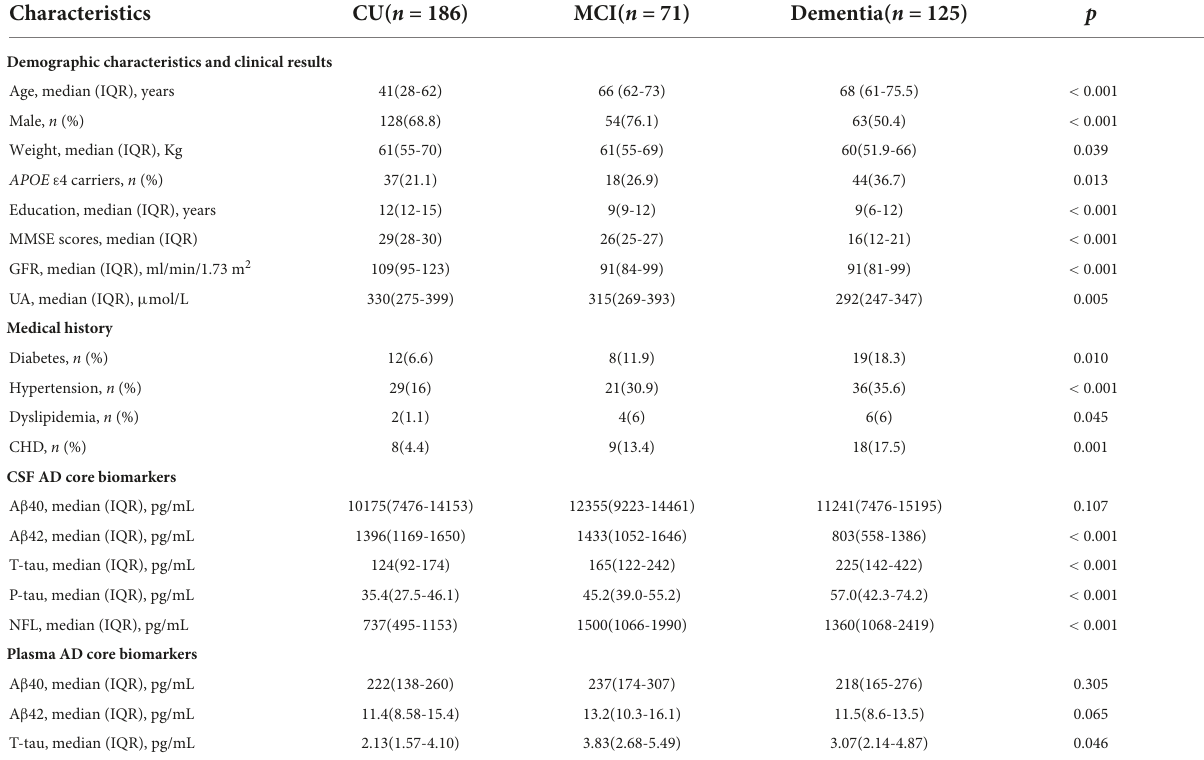
TABLE 1 Characteristics of the cohorts from